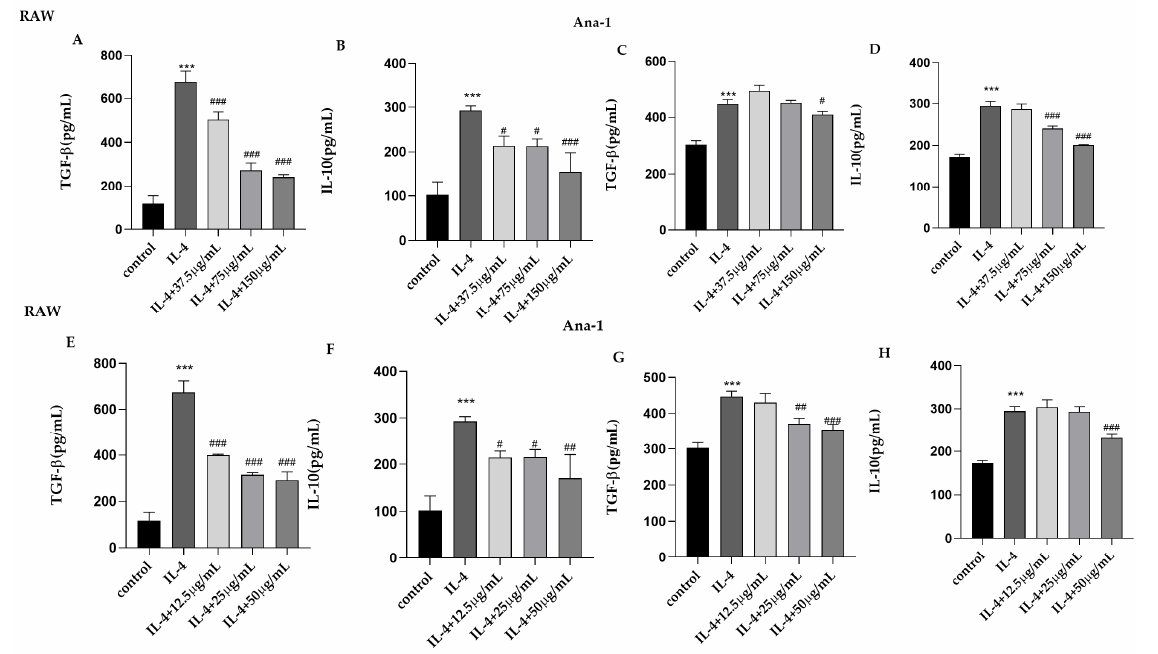
Figure 6. Effects of CII-3 and pericanaside ( 5 ) on the expression of TGF- β and IL-10 in IL-4-induced Figure 6 . Effects of CII-3 and pericanaside ( 5 ) on the expression of TGF-  and IL-10 in IL-4-in- RAW 264.7 and Ana-1 cells. TGF- β ( A ) and IL-10 ( B ) expression in RAW 264.7 cells treated with duced RAW 264.7 and Ana-1 cells. TGF-  ( A ) and IL-10 ( B ) expression in RAW 264.7 cells treated with CII-3; TGF-  ( C ) and IL-10 ( D ) expression in Ana-1 cells treated with CII-3. TGF-  ( E ) and IL- CII-3; TGF- β ( C ) and IL-10 ( D ) expression in Ana-1 cells treated with CII-3. TGF- β ( E ) and IL-10 10 ( F) expression in RAW 264.7 cells treated with pericanaside ( 5 ); TGF-  ( G ) and IL-10 ( H ) expres- ( F) expression in RAW 264.7 cells treated with pericanaside ( 5 ); TGF- β ( G ) and IL-10 ( H ) expression sion in Ana-1 cells treated with pericanaside ( 5 ). *** p < 0. 001 vs. the control group; # p < 0.05, ## p < in Ana-1 cells treated with pericanaside ( 5 ). *** p < 0.001 vs. the control group; # p < 0.05, ## p < 0.01, 0.01, and ### p < 0.001 vs. the IL-4 group. and ### p < 0.001 vs. the IL-4 group.